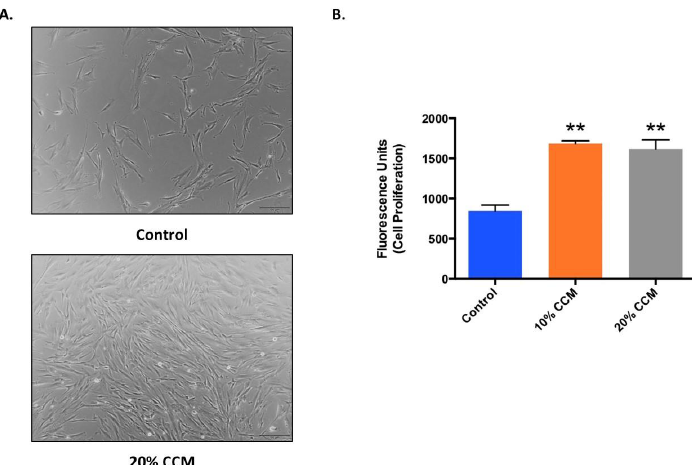
Figure 3. ( A ) Representative phase contrast images (size bar-100 µm) of human fibroblasts (CLL-171) treated with media only (control) and 20% CCM. ( B ) Alamar Blue assay for proliferation of CLL-171 treated with media only (control) and 10% or 20% CCM after 5 days. Data represents mean ± SEM, and ** represents significant difference ( p < 0.0001) between CCM treated groups and control group, 5 days post-treatment with stem cell extract. CCM was produced in two lots in duplicate from two vials and cell proliferation assay was performed using CCM from each lot three separate times in triplicate.